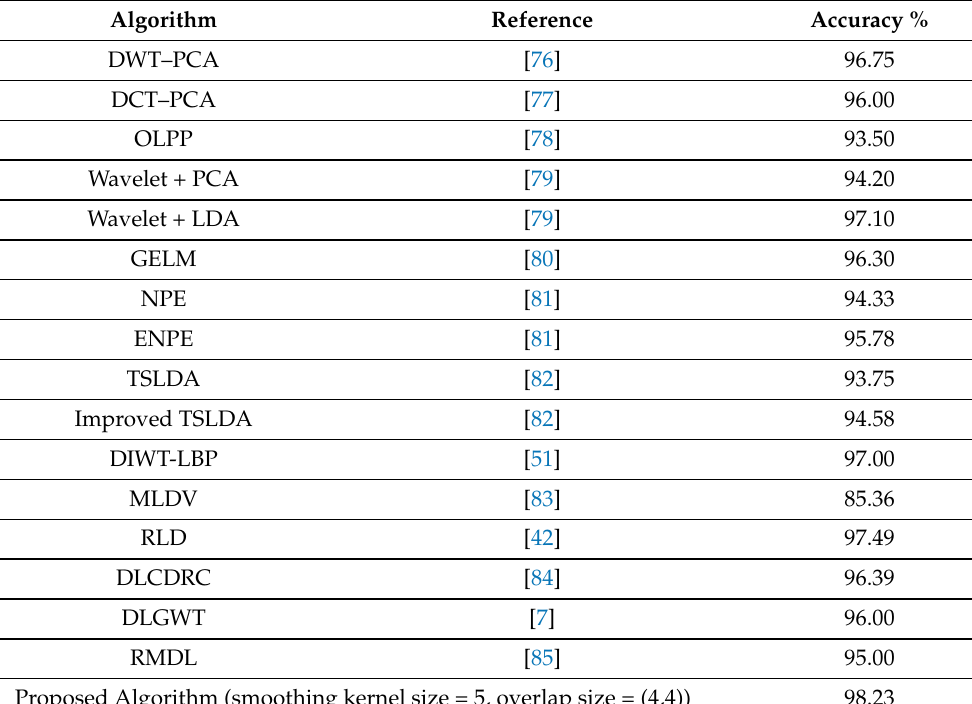
Table 4. Comparison with existing algorithms for ORL